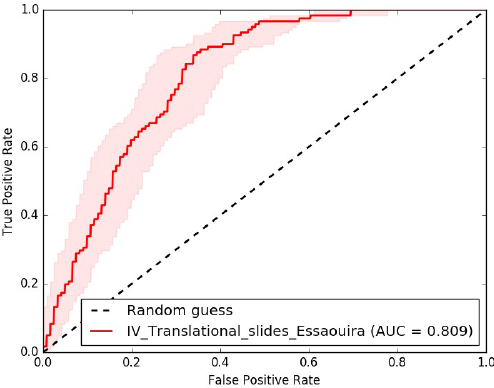
Figure 12. ROC curves of the susceptibility model for translational slides (AUC = 0.809).